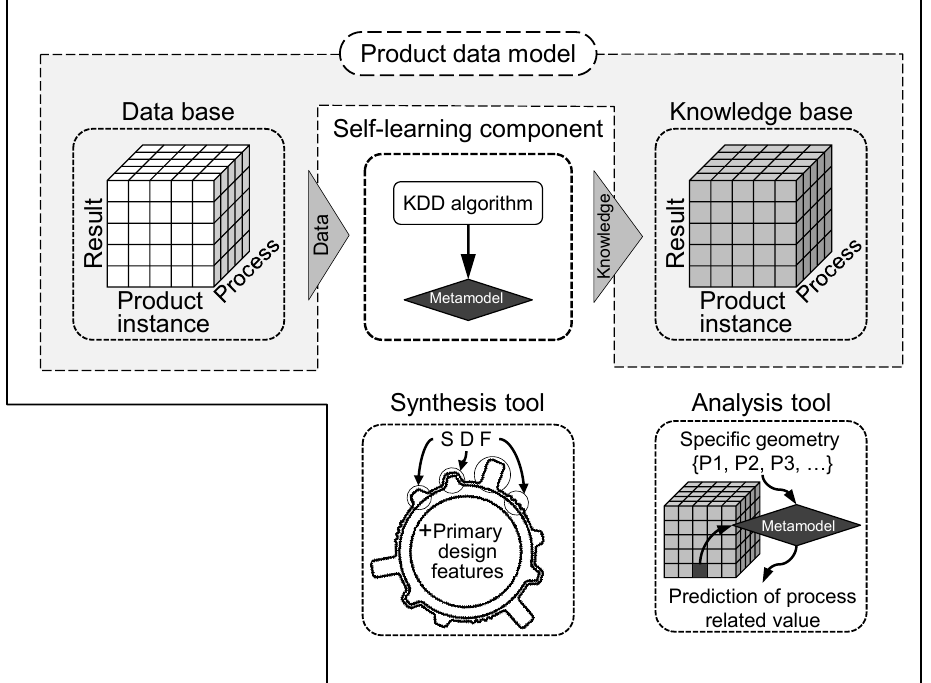
Figure 4. The overall architecture of SLASSY with the product data model, KDD process based self-learning component, synthesis and analysis tool and interface with the CAD-system according to